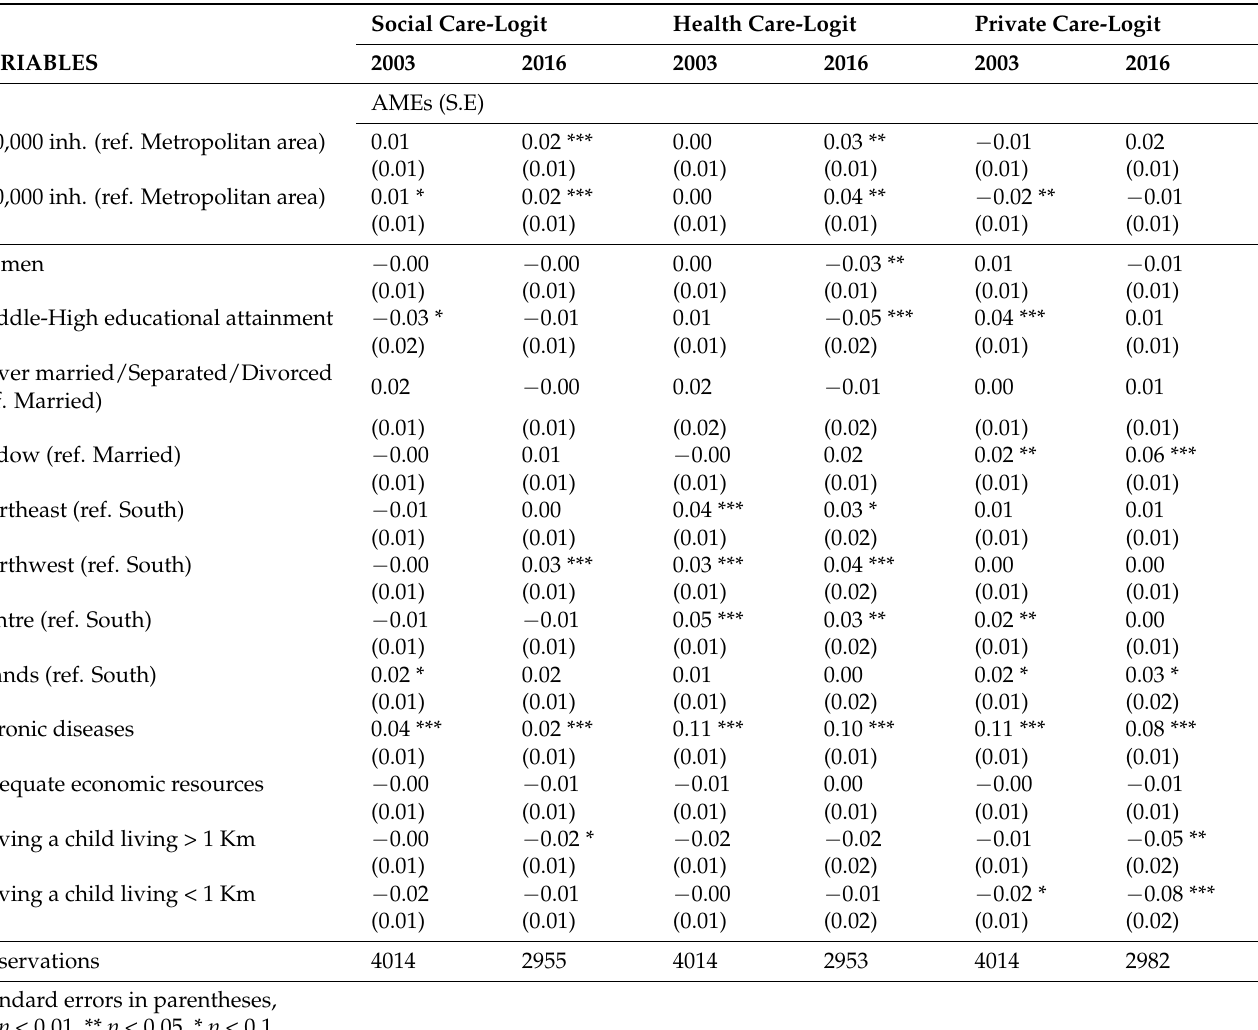
Table 2. Average marginal effects and robust standard errors from logistic regression models of social, health and private care